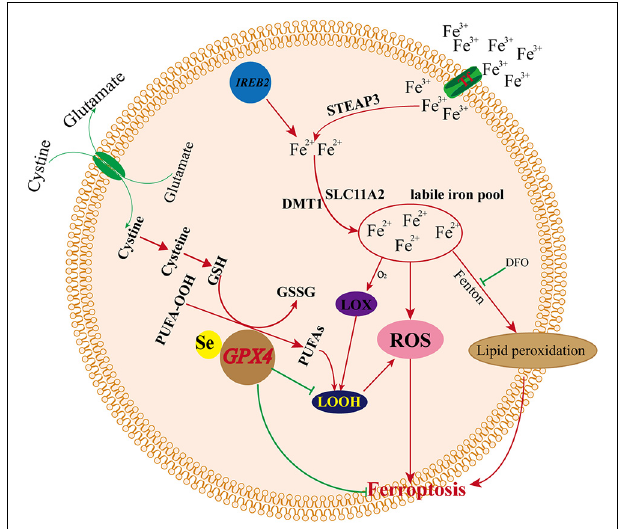
FIGURE 4 | Mechanism of ferroptosis and iron